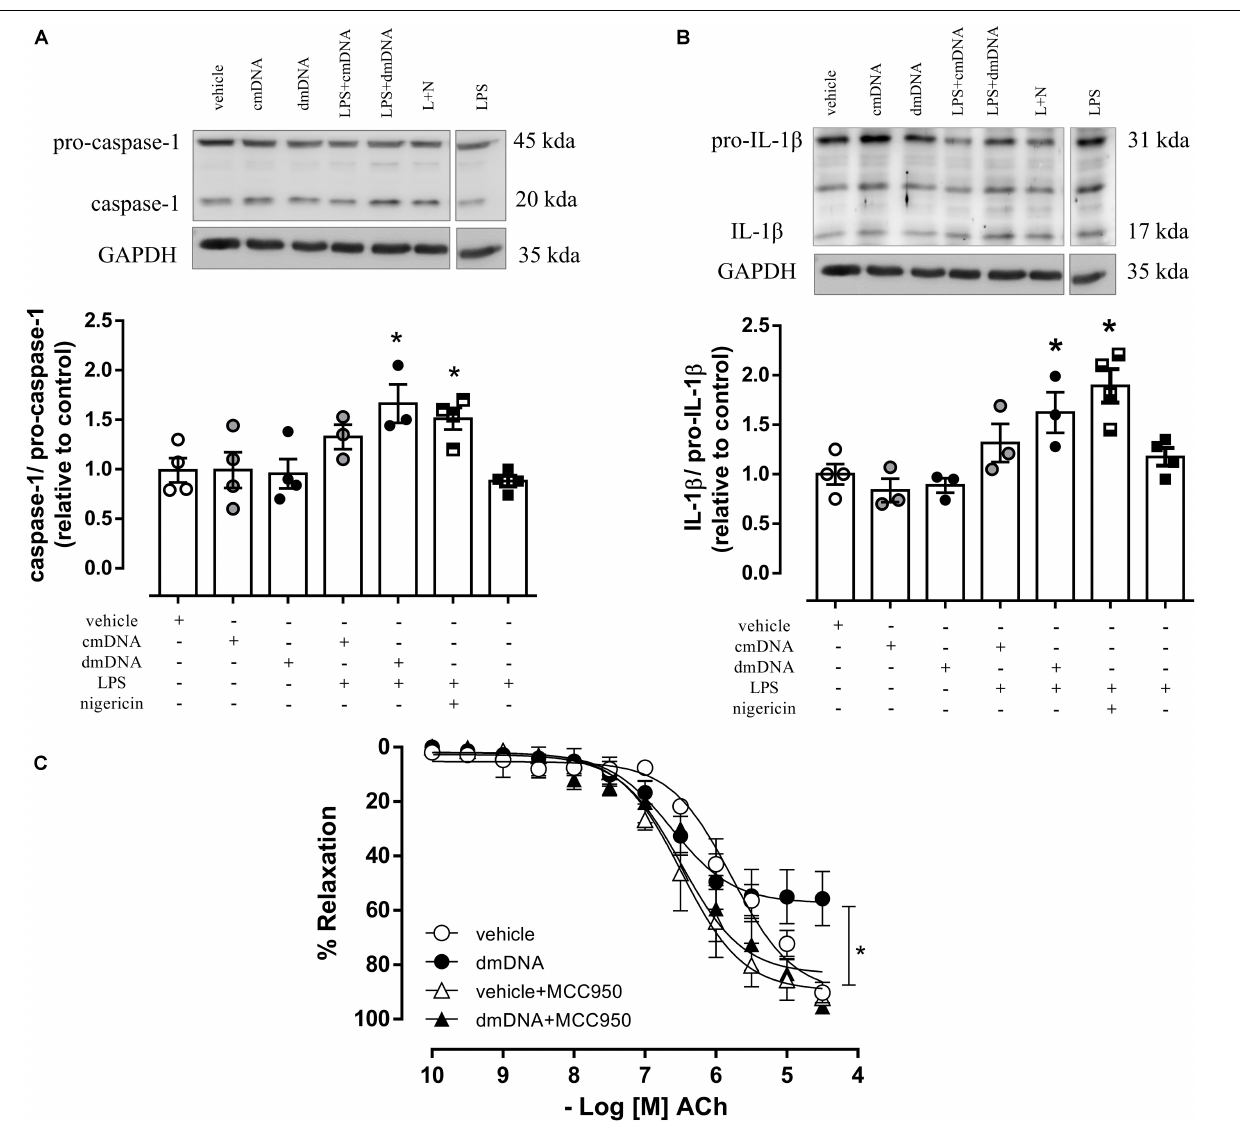
FIGURE 5 | On top, representative images of western blot and, at the bottom, densitometric analysis of the expression of (A) caspase-1 and pro-caspase-1 and (B) IL-1 β and pro-IL-1 β in endothelial cells primed with lipopolysaccharide (LPS) and incubated with vehicle (white squares) and mitochondrial DNA from control (cmDNA, white circles) and diabetic (dmDNA, black circles) mice. (C) Cumulative concentration-response curves to acetylcholine (ACh), endothelium-dependent vasodilator, in resistance mesenteric arteries from C57BL/6 incubated with vehicle (white circles) or mitochondrial DNA from diabetic mice (dmDNA, black circles) in the presence of vehicle (white triangles) or a NLRP3 inhibitor (MCC950, black triangles). Each point/column represents the mean ± SEM. ∗ P < 0.05 vs. vehicle. N = 3–5, one-way ANOVA (A–C)